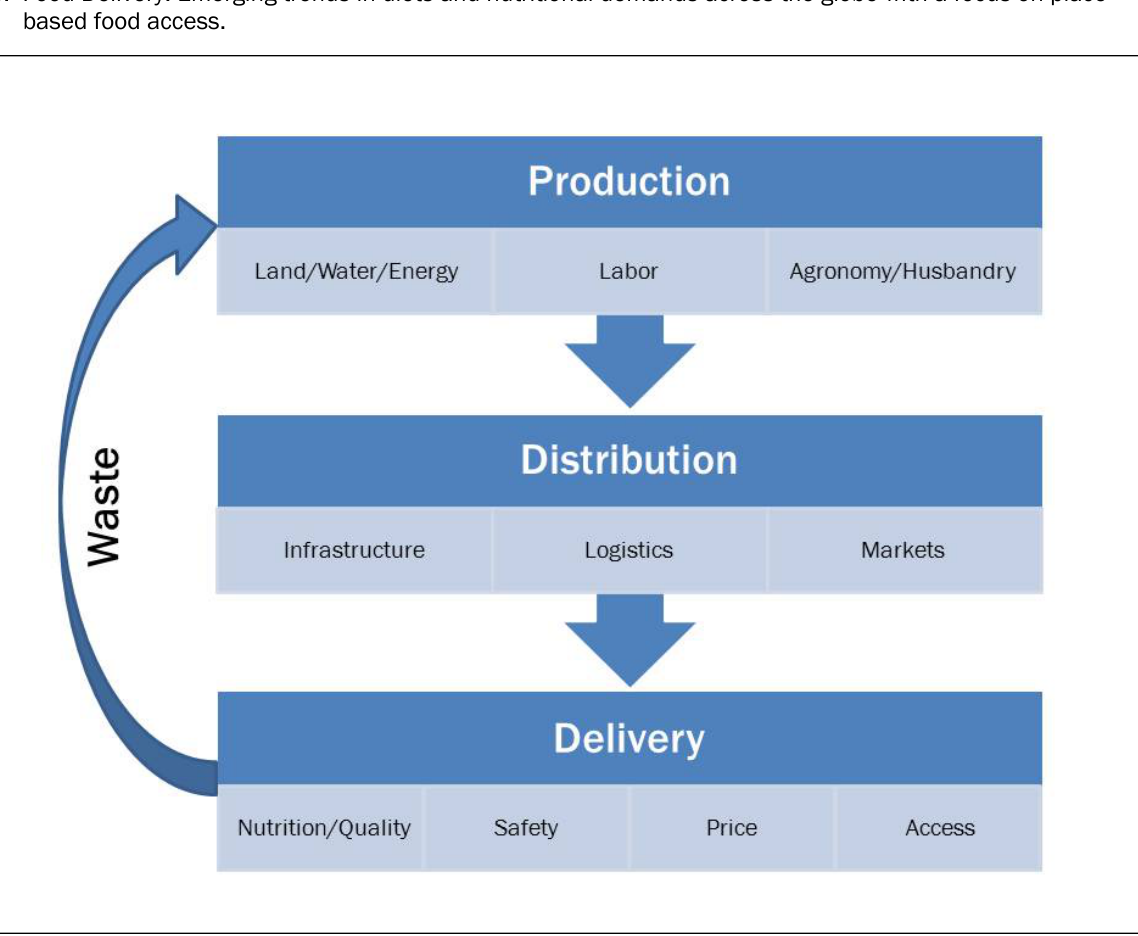
Figure 1. Domains of Food